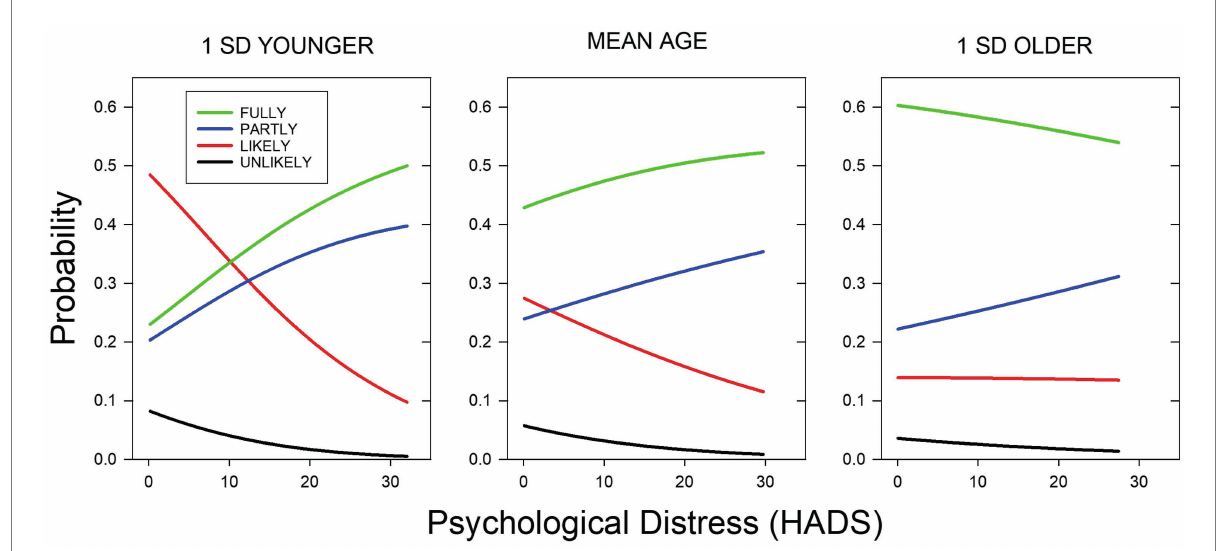
FIGURE 1 Probability of vaccination status as a function of HADS score for a participant whose age was the sample mean (46.9 years, center panel) and for participants 1 SD younger and older than the mean (ages 32.8 and 61.0 years, left and right panels, respectively). The probabilities of a person’s status being Unlikely, Likely, Partially, or Fully are represented by black, red, blue, and green lines, respectively. Vaccination status probabilities are depicted for HADS scores up to 2 SDs above the mean for each of the ages represented.